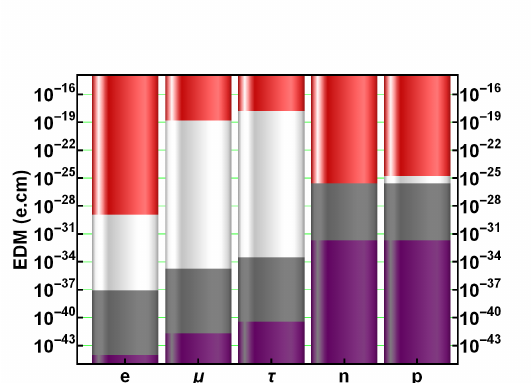
Figure 1. Current most stringent limits on the EDM (red) of the charged leptons and the lightest baryons displayed along the expected background from the CP-violating CKM-phase of the weak interaction (violet) and possible strong CP-violation (grey). The strong CP-violation assumes that θ is as large as allowed by the current limit on the neutron or 199 Hg EDM. Note that the lim- its on the electron and proton EDM are extracted under the sole source assumption from the measurements on ThO and 199 Hg, respectively, see Tab. 1. The limit on the tau uses that of the electron. The CKM contributions are the estimated fourth order loop contributions to the electron [6] and scaled for muon and tau. The CKM contributions to neutron and proton may vary by an order of magnitude or so, compare e.g. [7]. (Figure courtesy of P. Mohanmurthy)